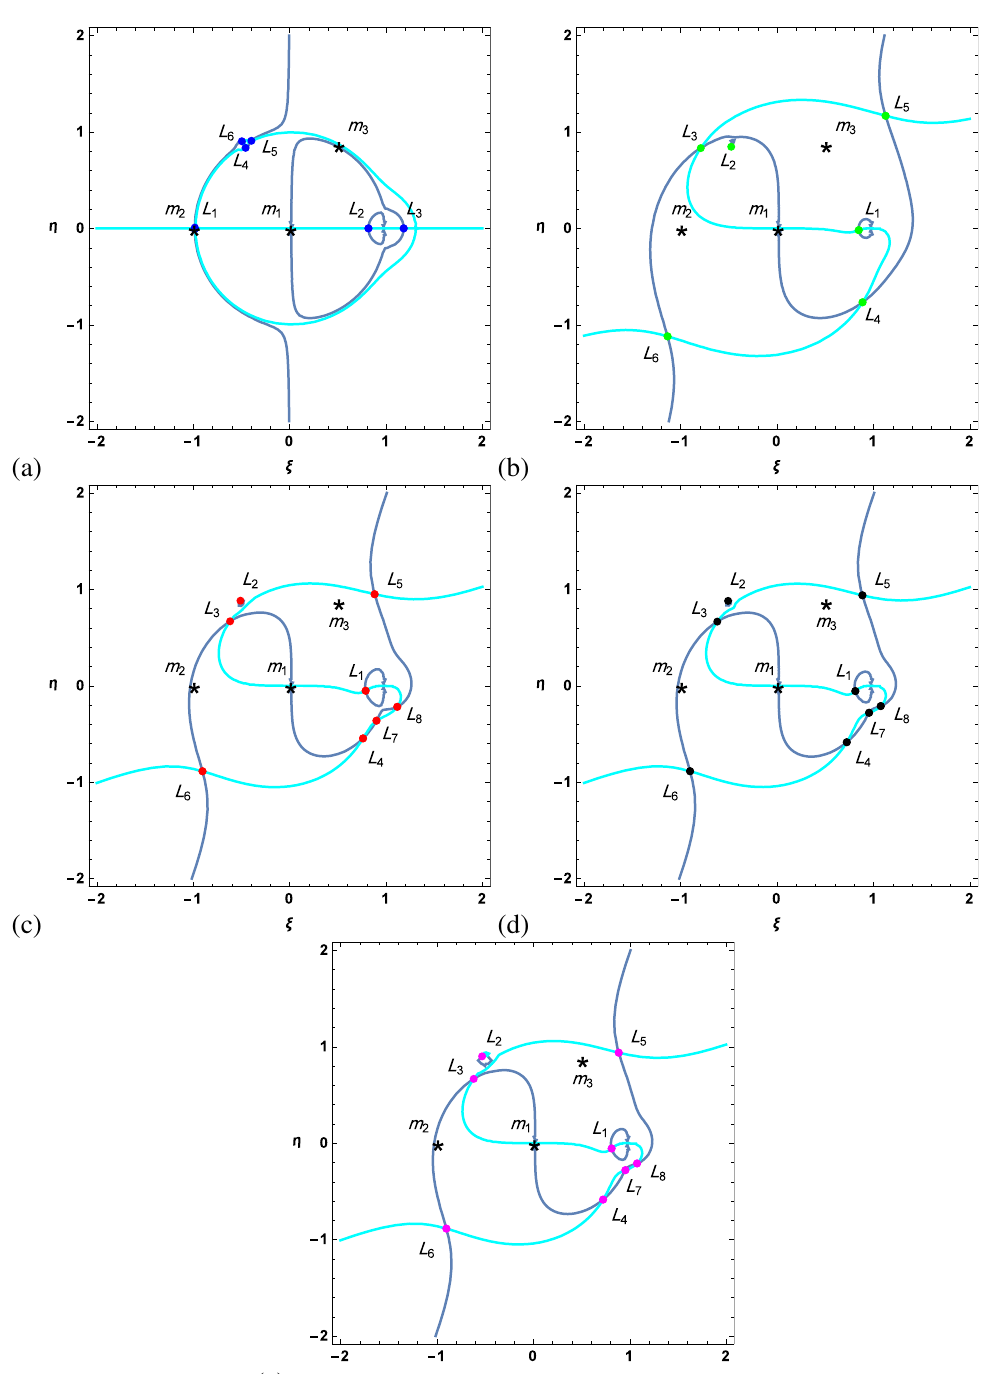
Fig. 2 The locations of lagrangian points during in-plane motion (i.e. ξ (cid:54) = 0 , η (cid:54) = 0 , ζ = 0) in five cases: (a). Third primary is placed at one of the lagrangian points of the classical circular restricted three-body problem (points with blue color), (b). Variation of masses (points with green color), (c). Solar radiation pressure (points with red color), (d). Albedo effect (points with black color), (e). Oblateness effect (points with magenta